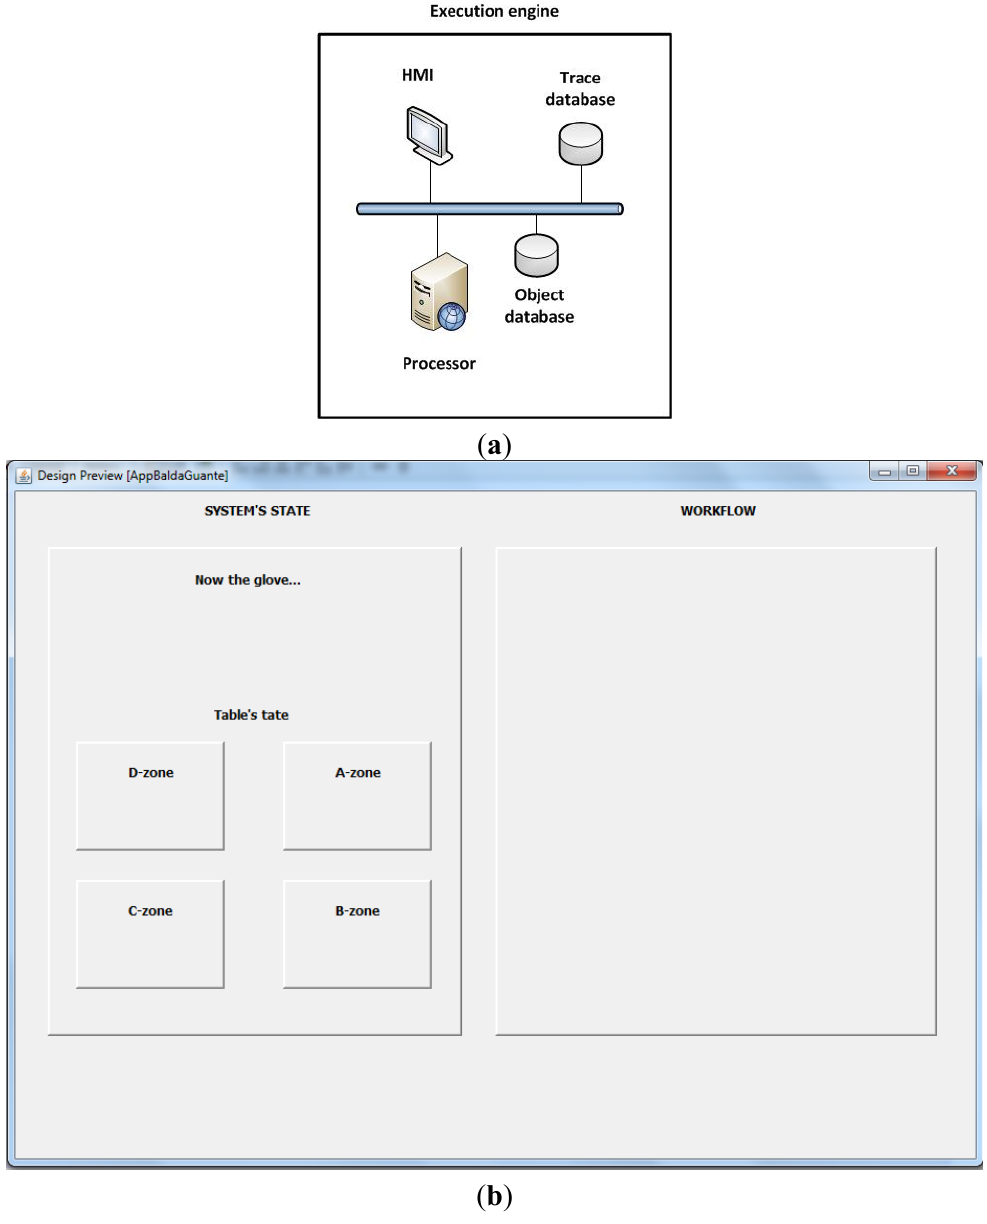
Figure 10. ( a ) Functional decomposition of the execution engine; ( b ) Visualization